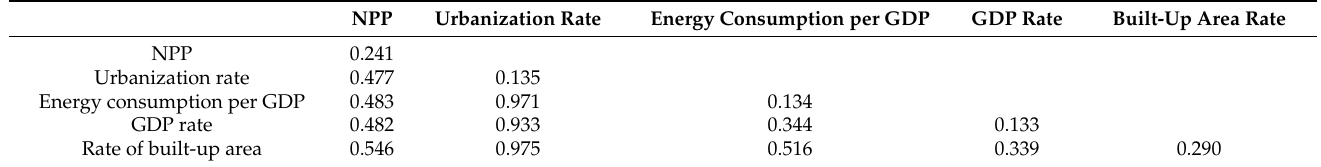
Table 5. The q values of different covariates under interaction detector.